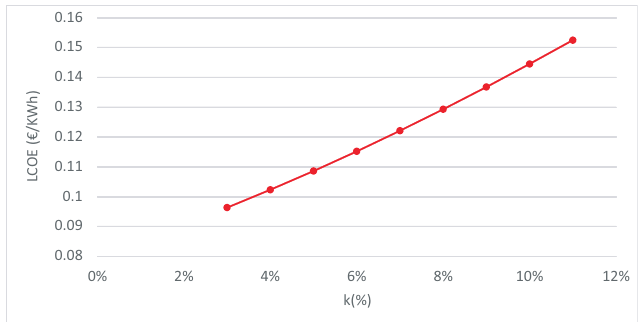
Figure 13. LCOE values for different values of the rate of return in the interval between k = 3% and k =